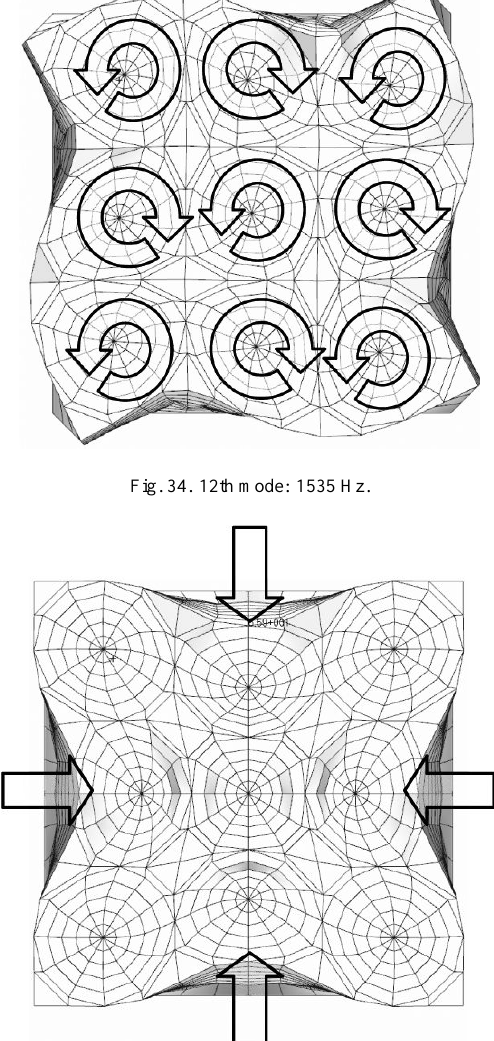
Fig. 35. 15th mode: 1700